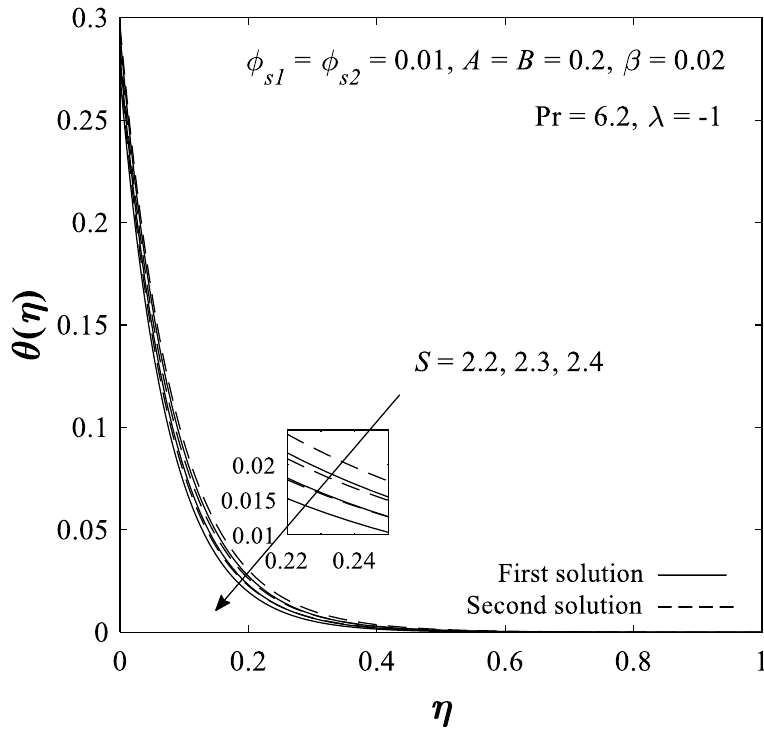
Figure 13. Temperature profile θ ( η ) for varied S .